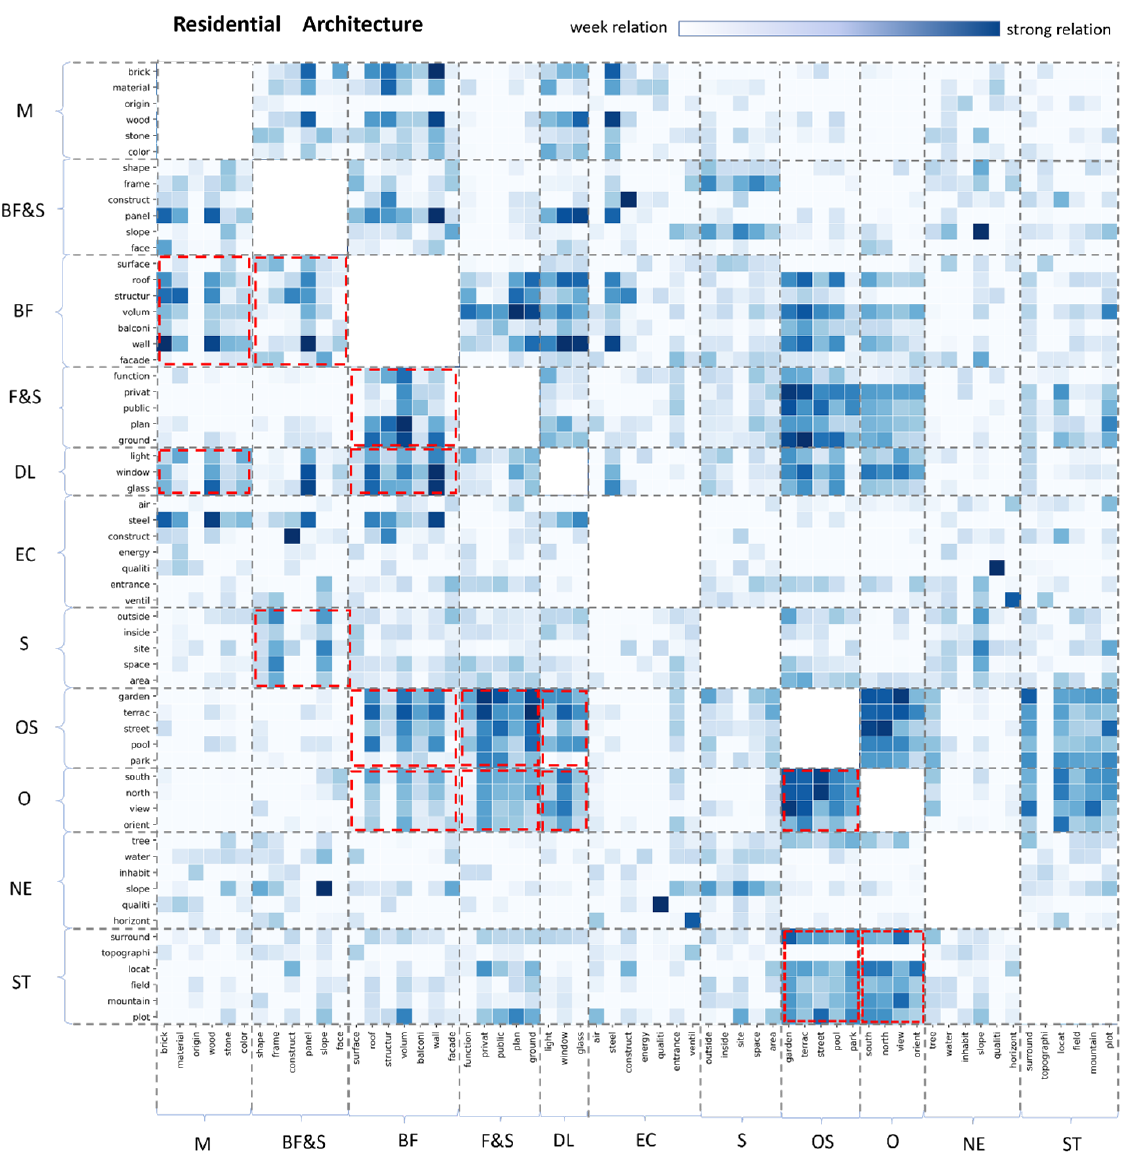
Figure 8. Heat map of clustered words related to residential